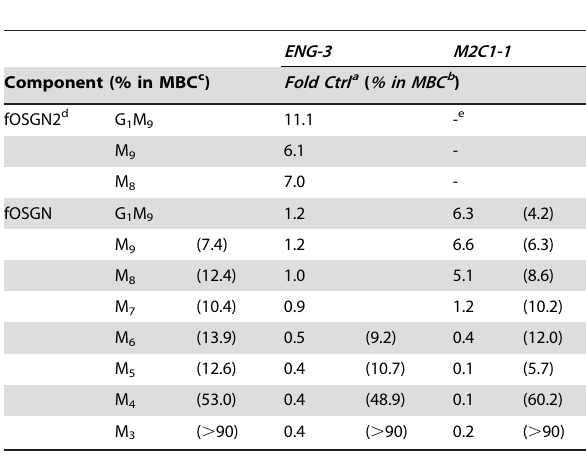
Table 1. The effects of MAN2C1- and ENGASE-targeted siRNA duplexes on fOS steady state levels in HepG2